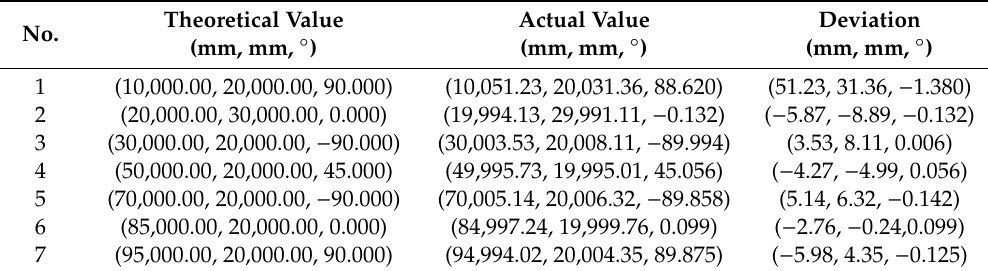
Table 4. Theoretical and actual positions and postures at each station of the first test.